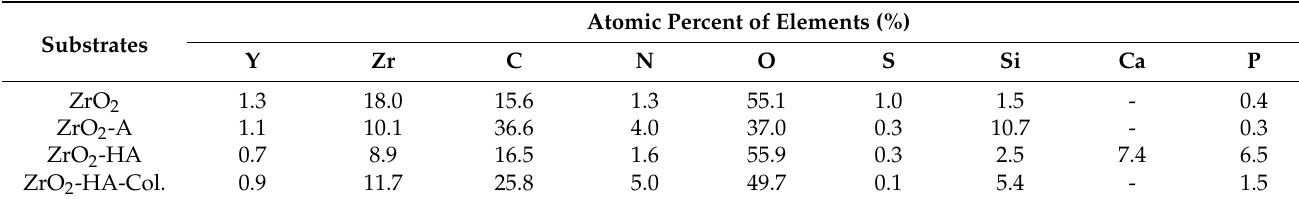
Table 1. Atomic percentages of surface modified ZrO 2 implants calculated from the XPS survey scan spectra.